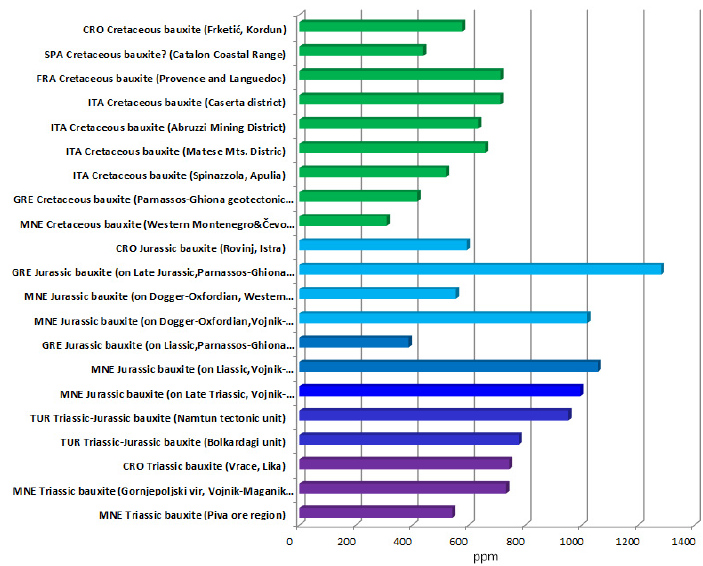
Figure 17. Content comparation of Σ REE + Sc in the bauxite formations in Montenegro and some Mesozoik Mediterranean bauxite formations, (ppm).